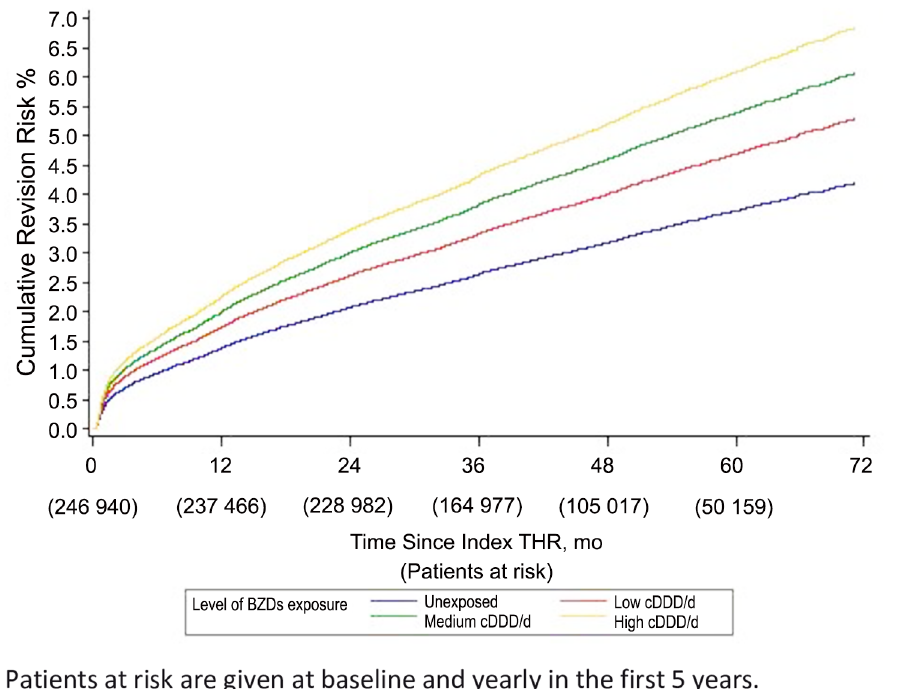
Fig 2. Kaplan Meier Cumulative Revision Risk According to Level of Exposure to